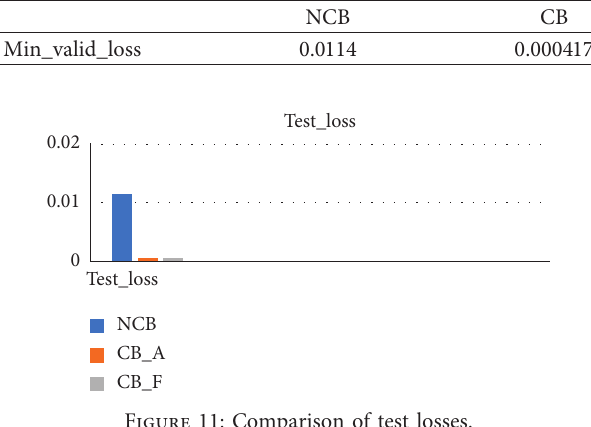
Table 2: Comparison of minimum verification loss.